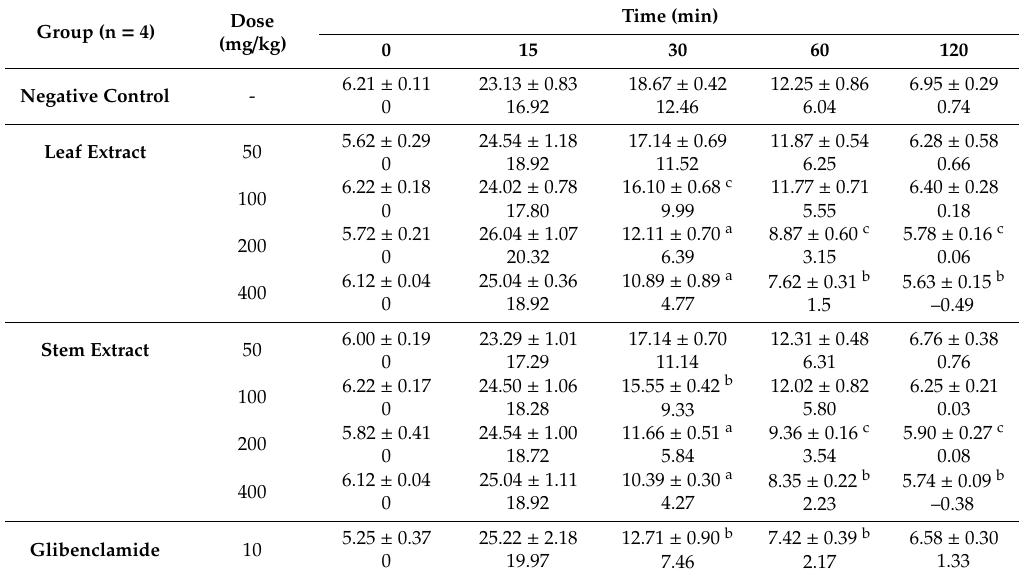
Table 5. E ff ect of methanol extracts of U. bojeri leaves and stems on mice blood glucose level (mmoles / L). Dose Group (n = 4) (mg / kg)